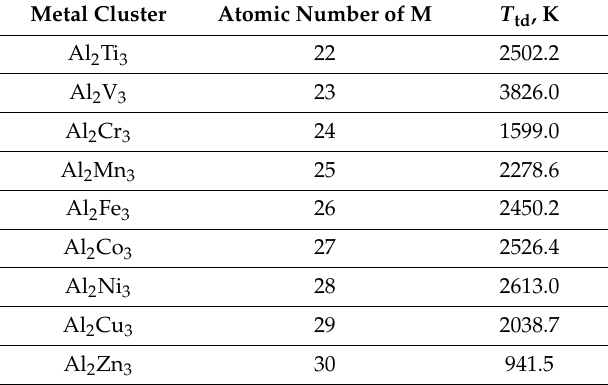
Table 7. Thermal destruction onset temperatures ( Ttd ) for energetically most stable Al2M3 metal clusters